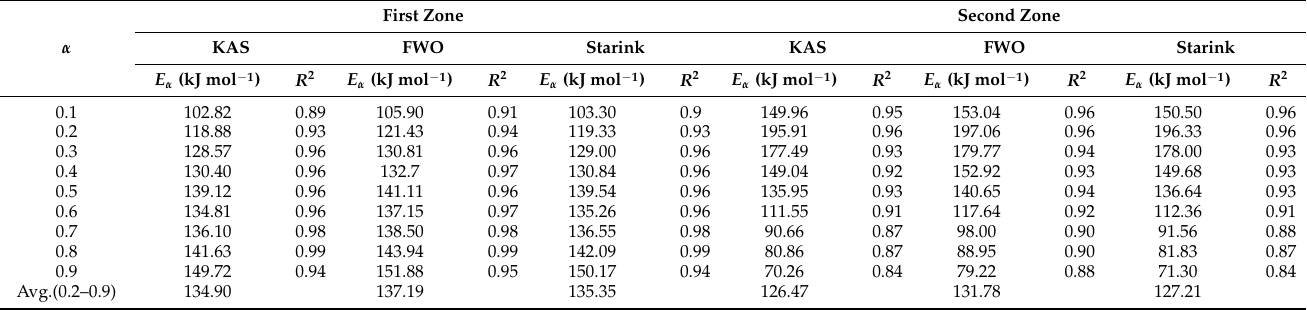
Table 7. Activation energy ( E α ) obtained by model-free methods for CS.